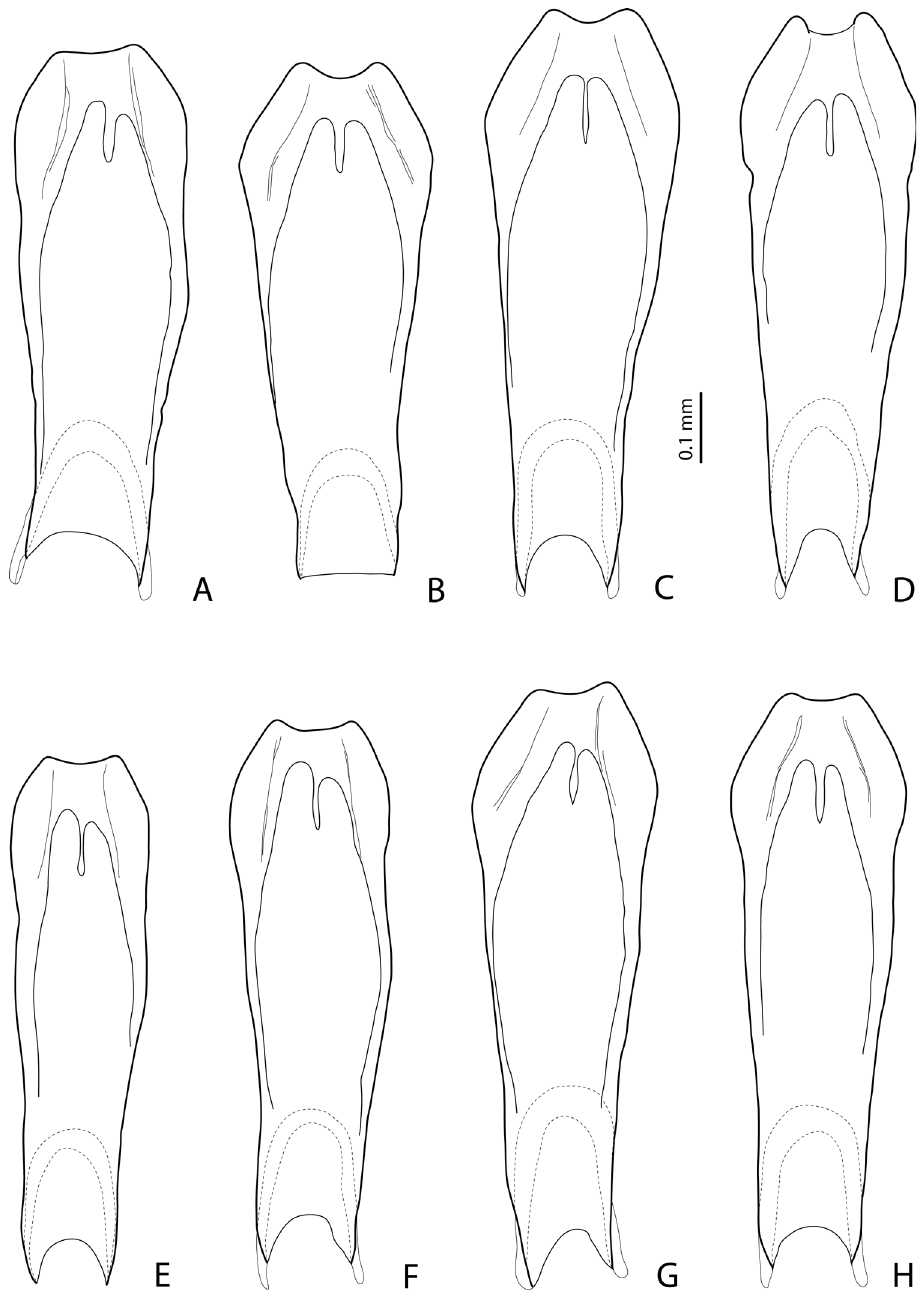
Figure 12. Exocelina damantiensis (Balke, 1998), PNG, median lobe in ventral view, setae are not shown A Simbu, Mount Wilhelm B Simbu/EHL, Wara Sera, PNG10 C, D Simbu/EHL, Hulene River, PNG17 E Madang, Brahman-Bundi, paratype of E. madangensis (Balke, 2001) F Madang, Akameku-Brahman, PNG114 G, H Madang, Damanti, paratypes of E. damantiensis